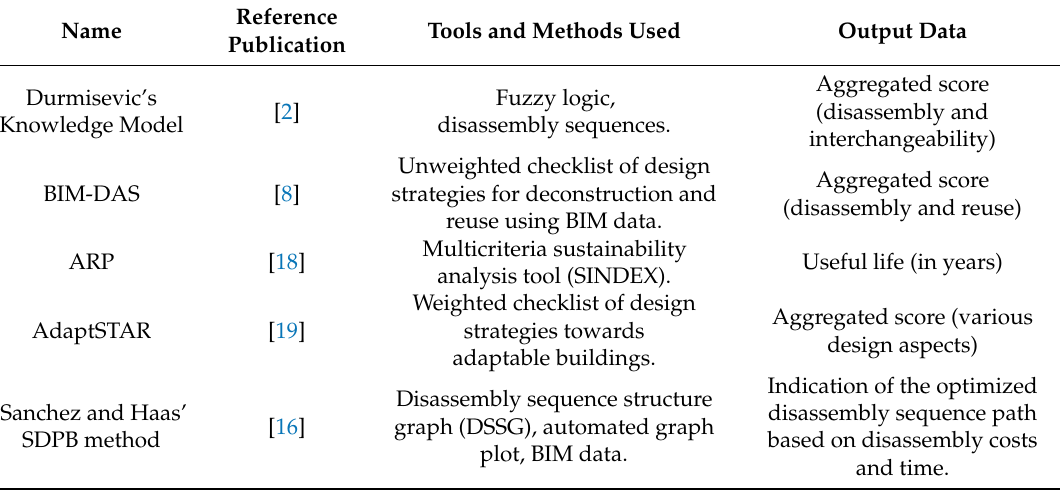
Table 1. Review of five building assessment methods for Design for Disassembly: Durmisevic’s Knowledge Model, Building Information Modeling-based Deconstructability Assessment Score (BIM-DAS), adaptive reuse potential (ARP), AdaptSTAR, and Sanchez and Haas’ sequence disassembly planning for buildings (SDPB)